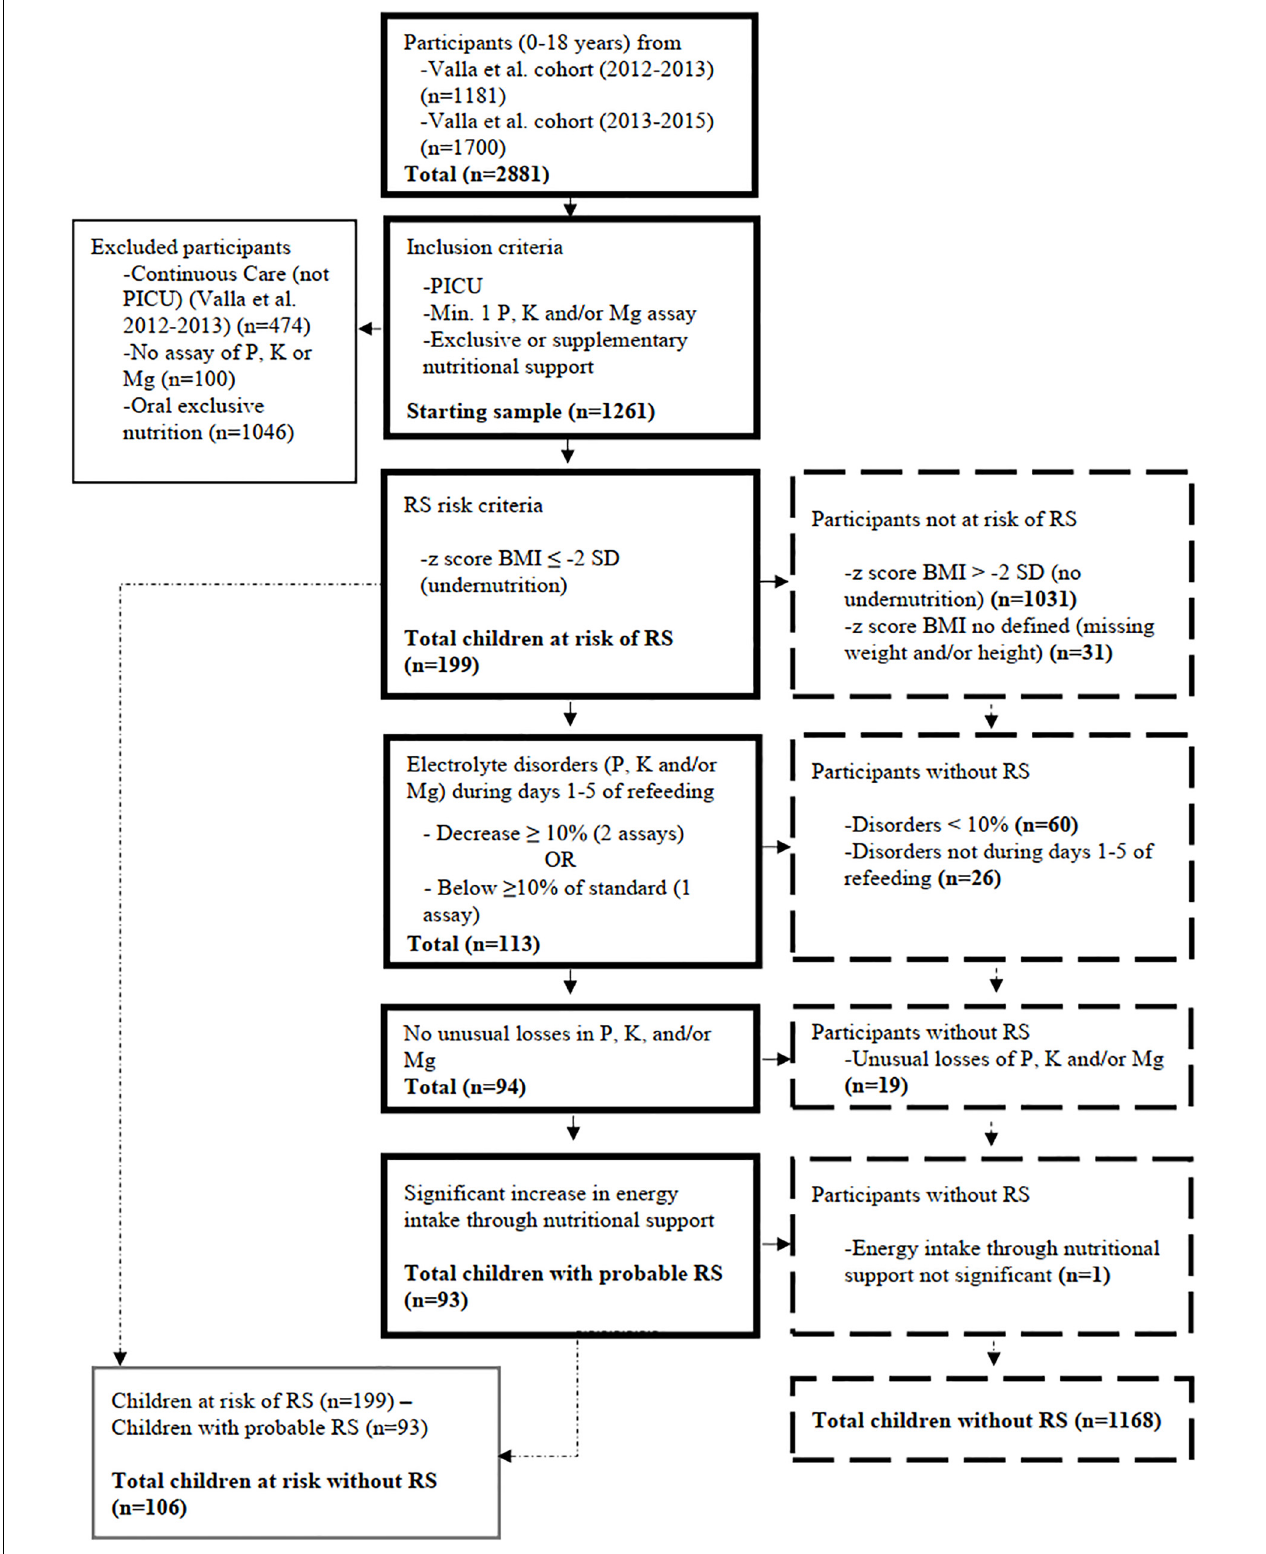
FIGURE 2 | Refeeding syndrome assessment results. BMI = Body Mass Index, K = Potassium, Mg = Magnesium, P = Phosphorus, PICU = Pediatric Intensive Care Unit, RS = Refeeding Syndrome, SD = Standard Deviation.